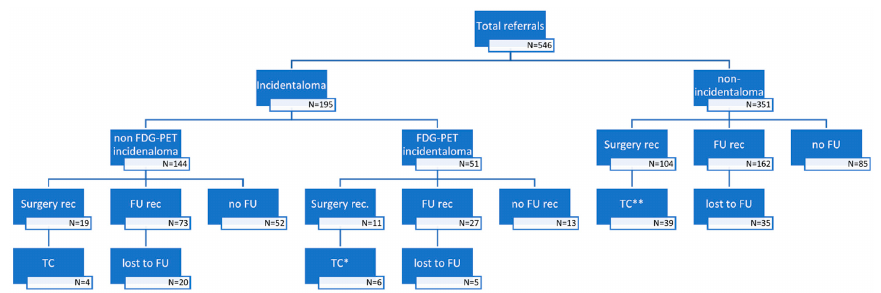
Figure 1. Patients flow and outcome. FU: follow-up; Surgery rec: surgery recommended; FU rec: follow-up recommended; no FU rec: no follow-up recommended; TC: thyroid carcinoma; * including 2 patients who did not undergo surgery but cytology indicated malignancy; ** including 4 patients who did not undergo surgery but cytology indicated malignancy. Table 1. Clinical characteristics of the patients.